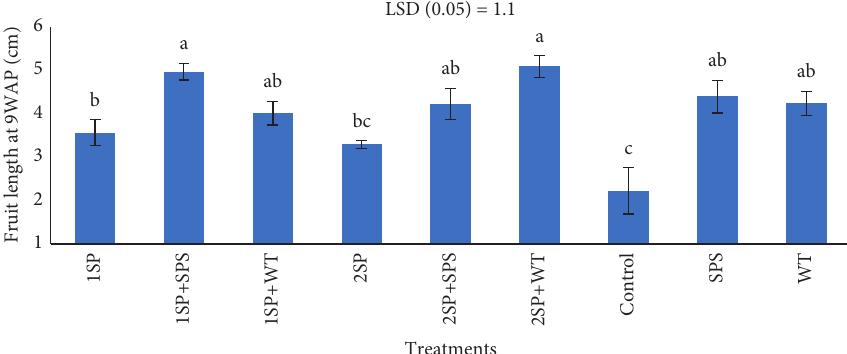
Figure 1: Effect of pruning and staking on fruit length. Bars with different letters denote significance at p < 0 . 05. Error bars denote the standard error of means. Means comparison was conducted using the least significant difference ( p < 0 . 05).